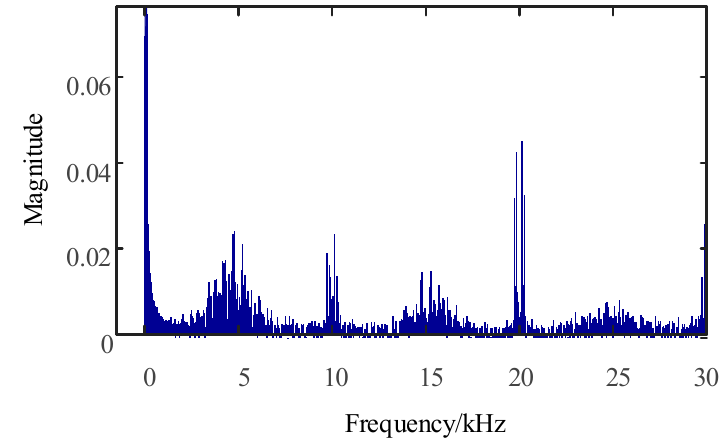
Figure 2. Inverter voltage spectrum under space vector pulse width modulation (SVPWM).